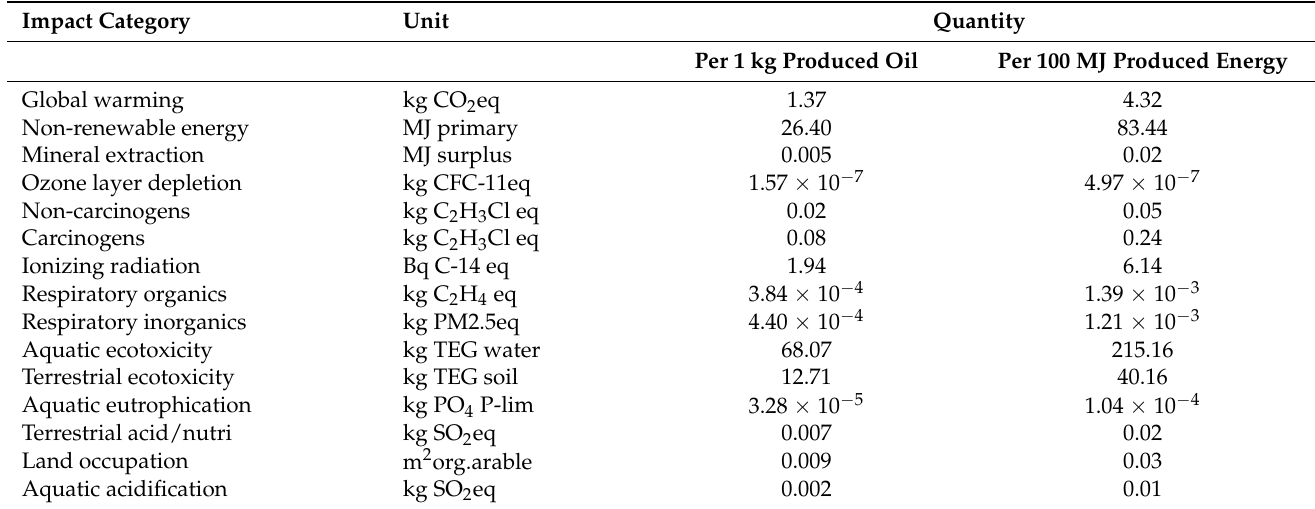
Table 2. Environmental consequence of the olive kernel oil production system based on different impact categories. Impact Category